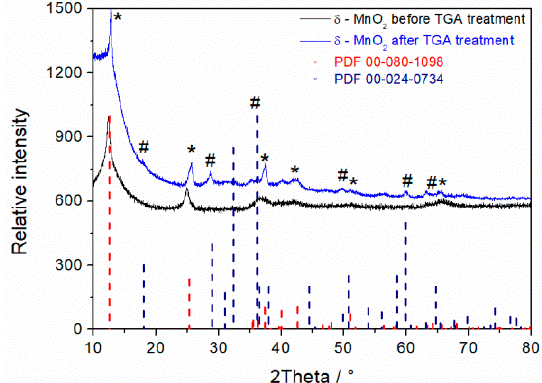
Figure A1. Influence of AlCl 3 ratio in EMIMCl/AlCl 3 mixture and electrolyte mass on Al species concentration (calculated values). The practicable molar ratio window lies between 1:1.2 and 1:1.9 (orange lines). At higher AlCl 3 concentration values, the mixture becomes solid.